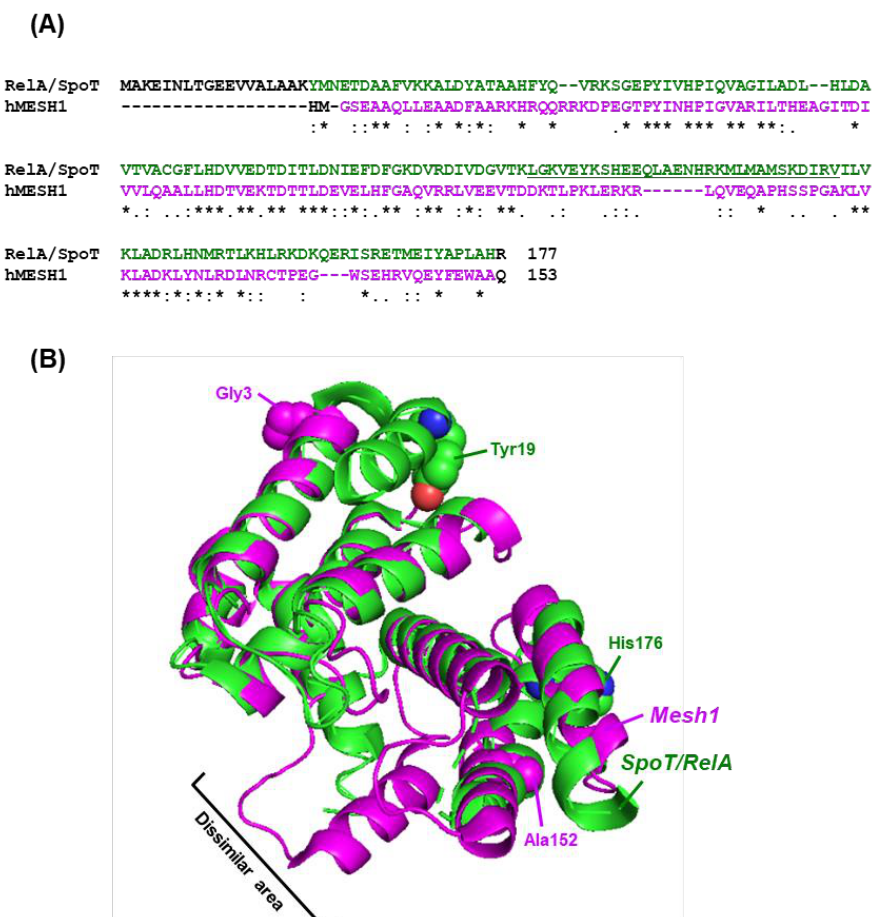
Figure 7. Sequence and structure homology between representative bacterial RelA/SpoT and human MESH1. The homologous regions of the two amino acid sequences, aligned by Clustal Omega ( A ), and the PDB structures of the same regions, aligned and superimposed by PyMol ( B ), are shown for the RelA/SpoT protein of the Gram (+)ve bacterium, Streptococcus equisimilis (PDB 1VJ7; 2.1 Å resolution) (Green color) and human MESH1 (PDB 5VXA; 2.1 Å resolution) (Magenta color). By the standard convention of Clustal alignment, the asterisk (*), colon (:), and period (.) indicate identical, strongly similar, and weakly similar residues, respectively. The total length of the SpoT/RelA protein is 387 amino acids, while the MESH1 protein is 180 residues long, of which only the N-terminal homologous regions are shown in both panels to conserve space. As shown, this region is free of beta strands and made exclusively of alpha helices connected by short loops (Panel B ), and a dissimilar region of ~30 amino acids (underlined in Panel A ) separate the two homologous clusters of helices (Panel B ). Also in panel B, the N-terminal and C-terminal residues of these sequences are indicated, using the same color code as the proteins (namely Tyr19, His176 in Green for RelA/SpoT and Gly3, Ala152 in Magenta for human